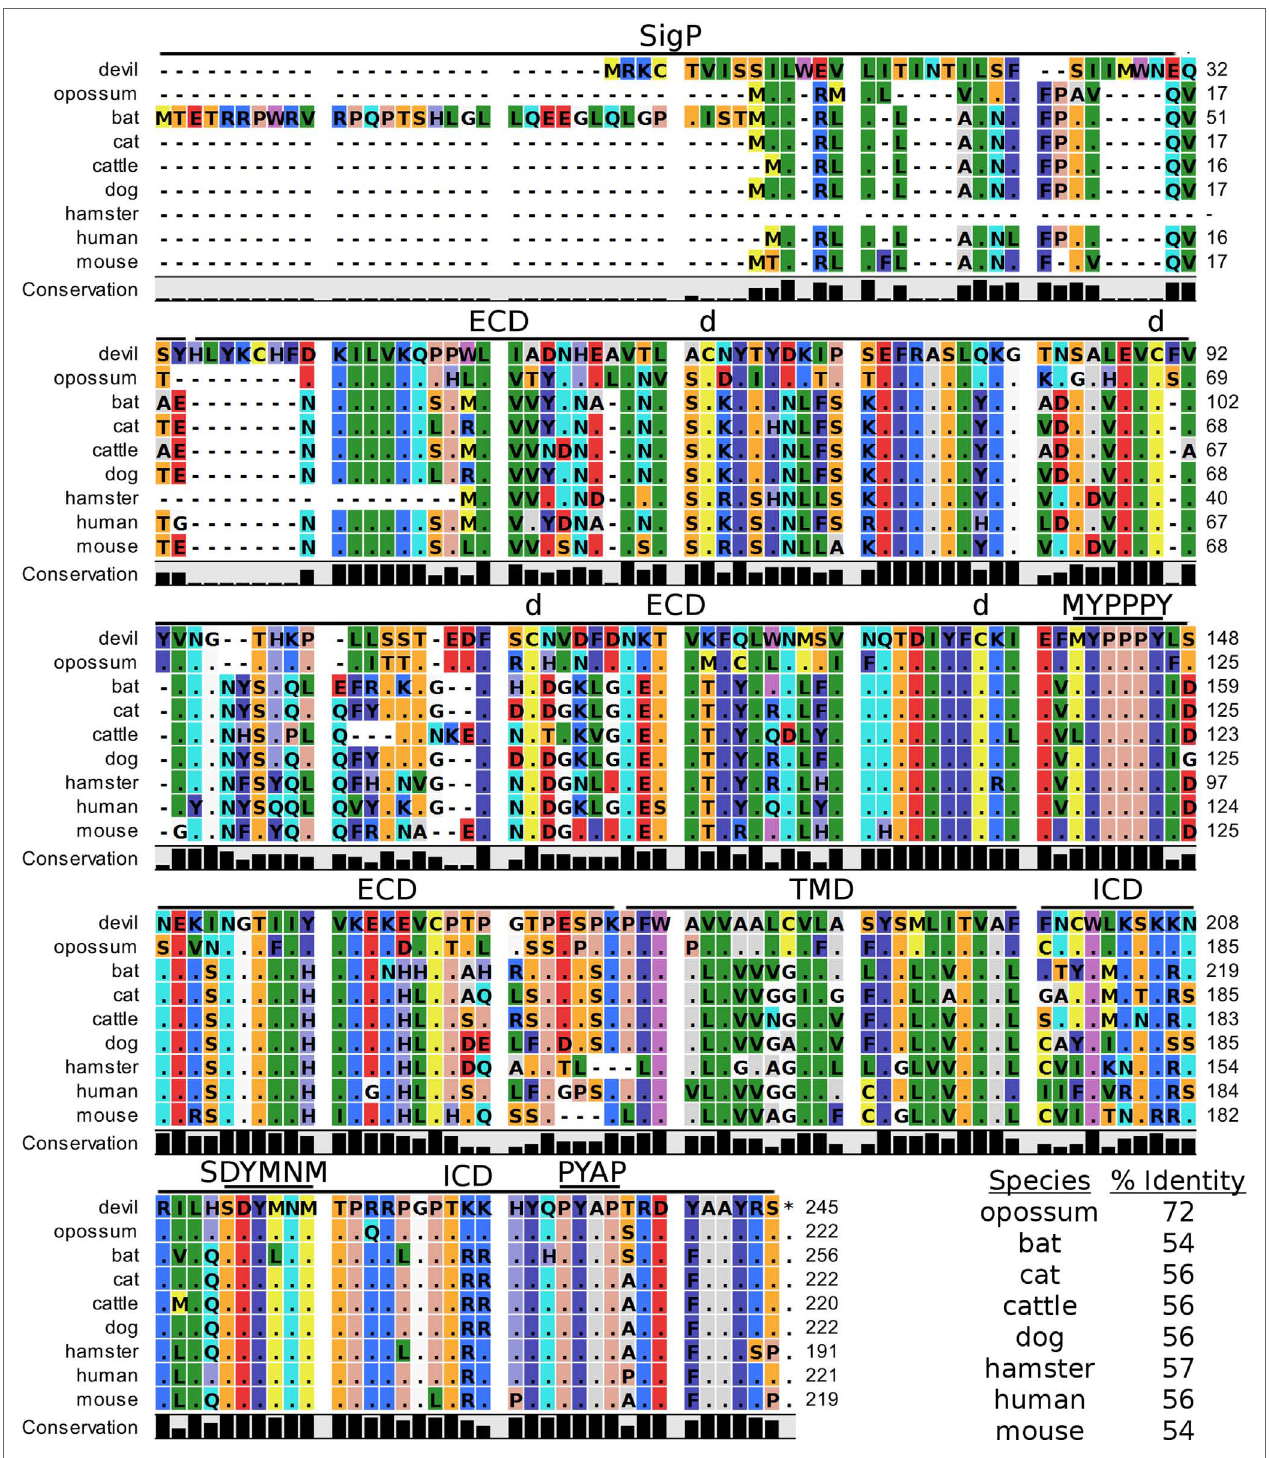
FigUre 3 | alignment of cD28 reference genes for nine species . The predicted signal peptides (SigP), extracellular domain (ECD), transmembrane domain (TMD), and intracellular domain (ICD) are demarcated with bars. “d” above the alignment represents predicted disulfide bonds. MYPPPY indicates the conserved CD80- and CD86-binding site, and SDYMNM and PYAP indicate key phosphorylation sites involved with cell proliferation and activation. The black bar graphs below the alignment represent the conservation of amino acids across all nine species. The percent amino acid sequence identity between devils and other species is shown in the bottom right corner of the